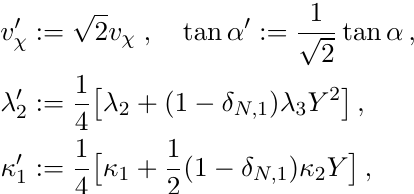
JHEP07(2017)113